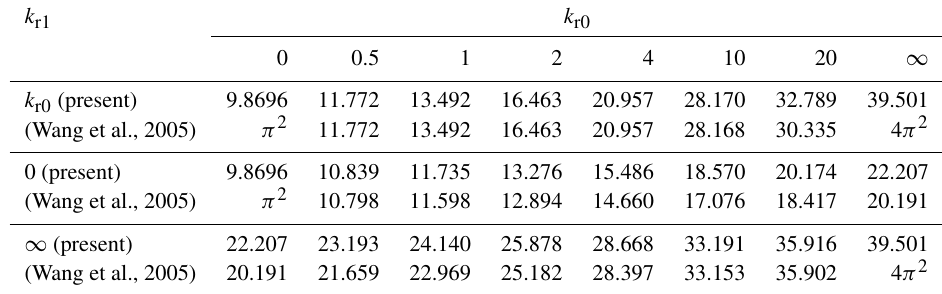
Table 1. Critical buckling load p ( q = 0) for various elastic constraint values with k t = ∞ and µ = 0 (local column).